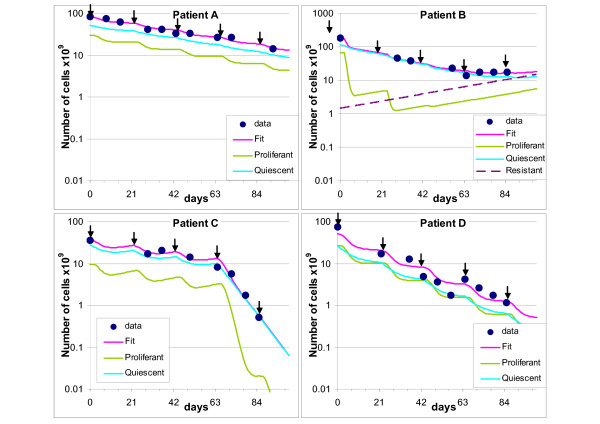
Examples of fitting. Representative examples of fitting (continuous magenta line) of experimental time courses (dots). The arrows indicate treatment times. Outlines of cycling (green line) and quiescent (light blue line) cells predicted by the model are also reported. Panel A: fitting with a level I model, with Sp = 0.68 and Sq = 0.98 (k = 0.50). Panel B: fitting with a level II model, including a subpopulation of cells resistant to treatment (dashed line). The fit was obtained with Sp = 0.04, Sq = 0.90 and IniR = 0.01 (k = 0.83). Panel C: fitting with a level III model, with an increase of efficacy from the fourth cycle. The fit was obtained with Sp = 0.43 and Sq = 0.98 up to day 60 and Sp = 0.004 and Sq = 0.98 thereafter (k = 0.50). Panel D: an example of unsatisfactory fit, with Sp = 0.34 and Sq = 0.98 (k = 0.50).